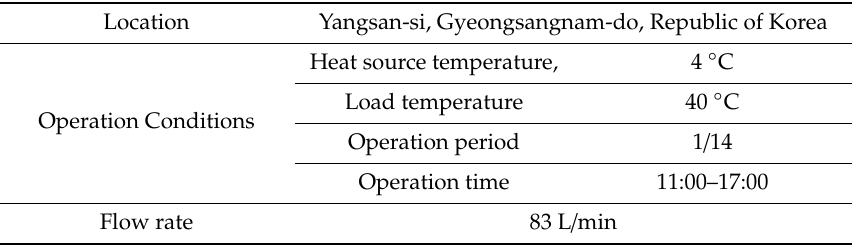
Figure 9. Schematic of GSHP system for the prototype of modular GHXs.